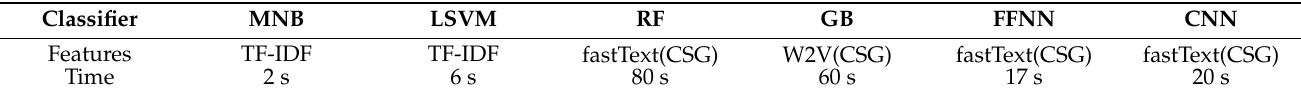
Table 11. Comparison of time performance of machine learning models on RU-PHS